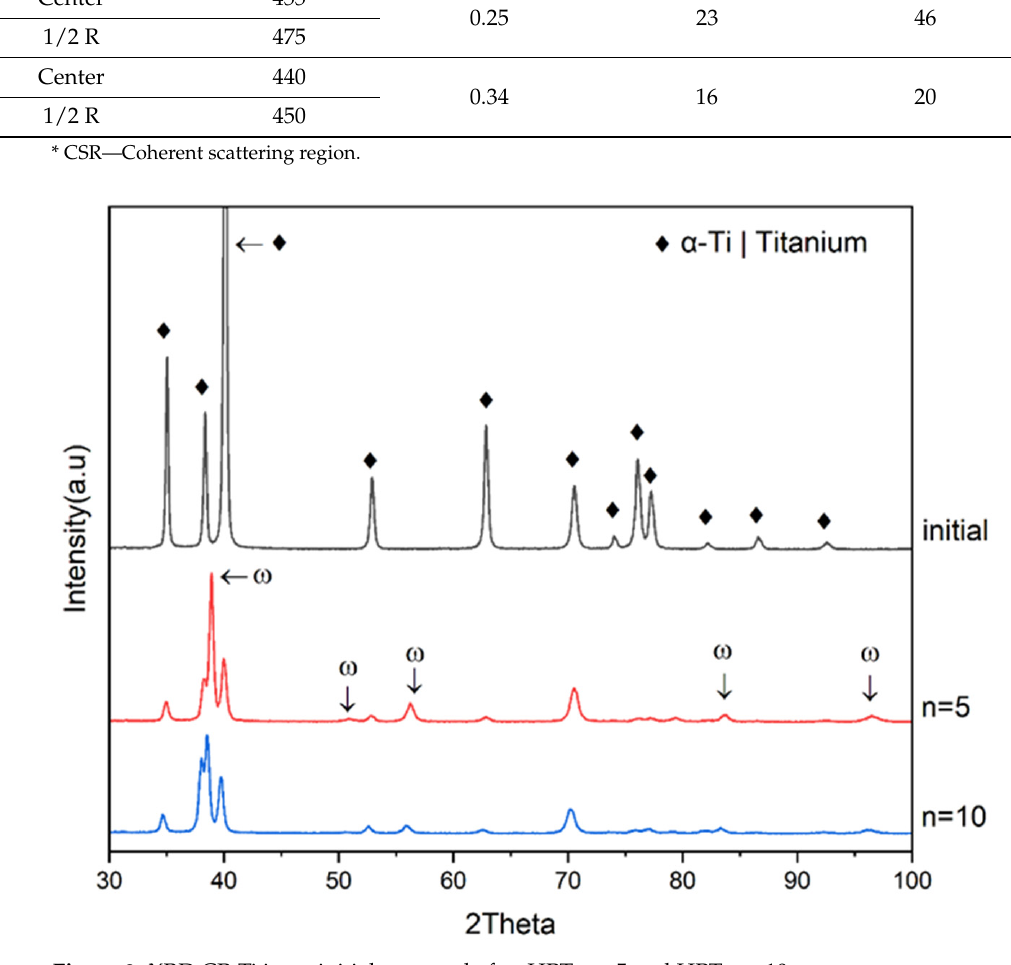
Figure 3. XRD CP-Ti in an initial state and after HPT n = 5 and HPT n = 10. Table 2. Results of HV measurements and the XRD analysis of Ti before and after HPT.